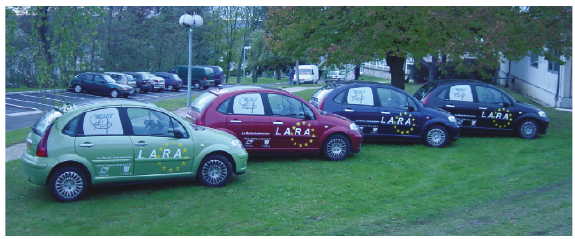
Figure 2: Prototype vehicles used in the field experiments. x of MRs in the mobile network, the number y of